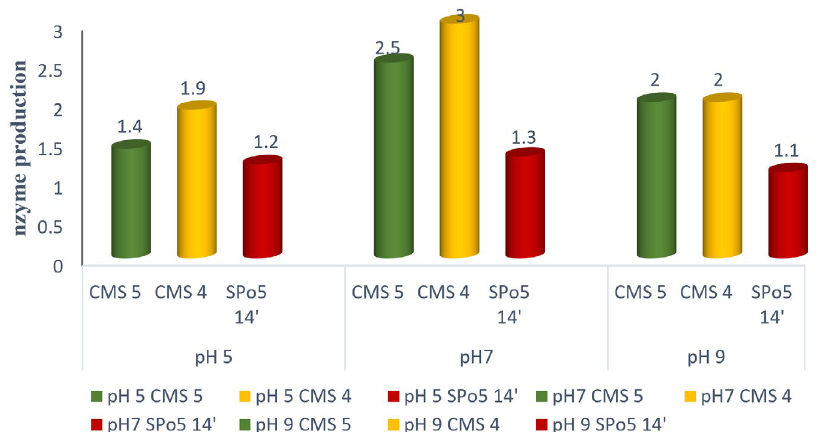
Fig. 7. Effect of pH on the enzyme production of three Bacillus strains: Bacillus subtilis (CMS5), Bacillus sp. (CMS4) and Bacillus velenzensis (SPo5